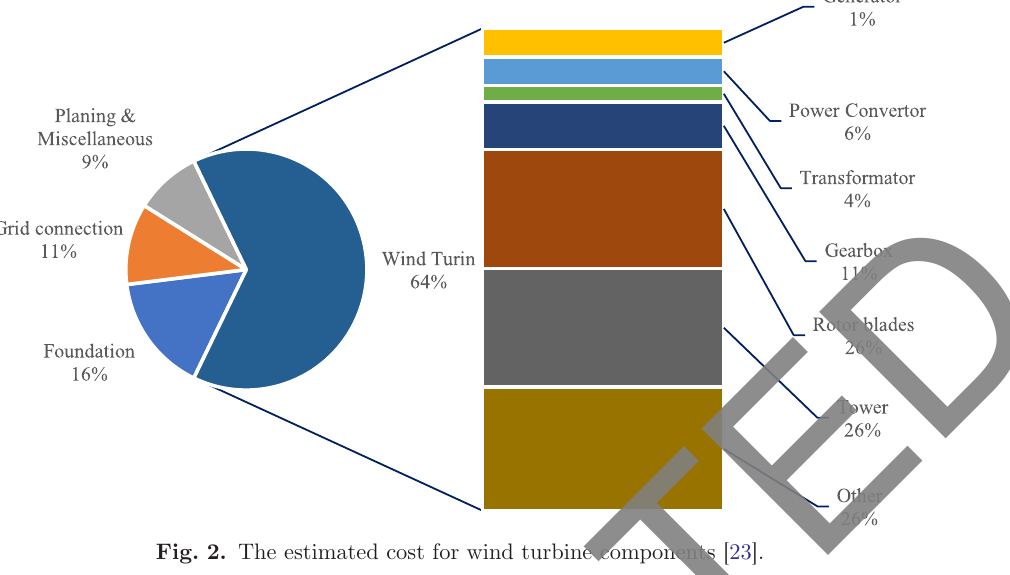
Fig. 2. The estimated cost for wind turbine components